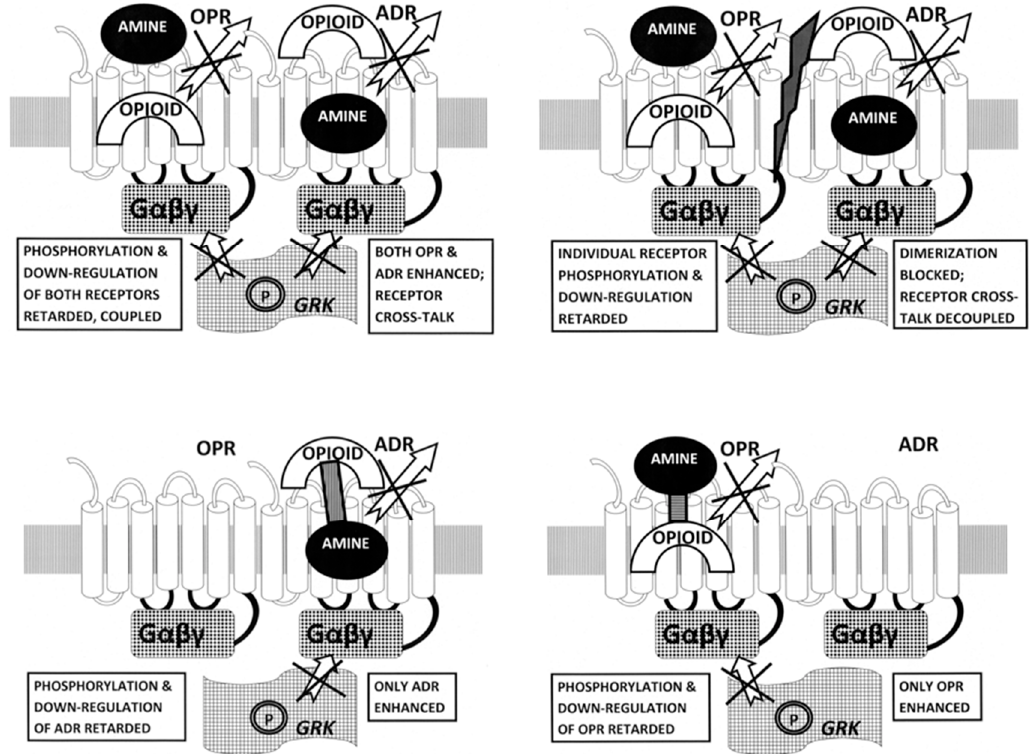
Figure 13. Drug development opportunities offered by a structural understanding of adrenergic receptor (ADR) co-evolution with opioid receptors (OPRs). Heterodimerization of ADR with OPR occurs when the ligands for both receptors are present (see Figure 10, Right) [8–16]. Top Left: The result of heterodimerization of ADR with OPR in the presence of both ligands is the enhancement of both receptors by the binding of the complementary compound to extracellular sites on the receptors. This binding of the complementary compounds enhances receptor activation by keeping the primary ligand in its high affinity pocket (either by allosteric changes in the structure of the receptors and/or by “capping” the binding site so that ligand is trapped for a longer period of time [40,56,64,65]. Heterodimerization also stimulates crosstalk between the receptors such that the G-protein coupling (G αβγ ) is enhanced and receptor kinase (GRK) binding is inhibited, so that phosphorylation of the receptors is prevented and down-regulation or internalization of the receptors is retarded (see Introduction). The overall effect is to increase the efficacy of any sub-maximal dose of the combined ligands, to increase their duration of activity, and to prevent tachyphylaxis and fade [40,56,64,65]. This model provides four novel opportunities for drug development. Top Left: The first opportunity is to optimize specific combinations of ADR and OPR agonists or antagonists to optimize receptor activation or deactivation. In particular, since opioid antagonists enhance ADR without activating OPR, and adrenergic antagonists enhance OPR without activating ADR, enhanced activation of particular sets of receptors is feasible. Top Right: Another drug development opportunity would be to develop drugs that inhibit heterodimerization (central slash), thereby decoupling the receptors, preventing crosstalk and possibly inhibiting the degree of co-activation of ADR with OPR. Bottom Left: A third opportunity would be to develop tethered drugs that optimize adrenergic ligand binding enhanced by a specific opioid or opioid antagonist. Again, since opioid antagonists enhance ADR without activating OPR, very specific activation (or deactivation, if an ADR antagonist were used) might be achieved. Bottom Right: Finally, using the same logic, it should be possible to develop tethered drugs that optimize opioid agonist or antagonist binding enhanced by a specific adrenergic agonist or antagonist.